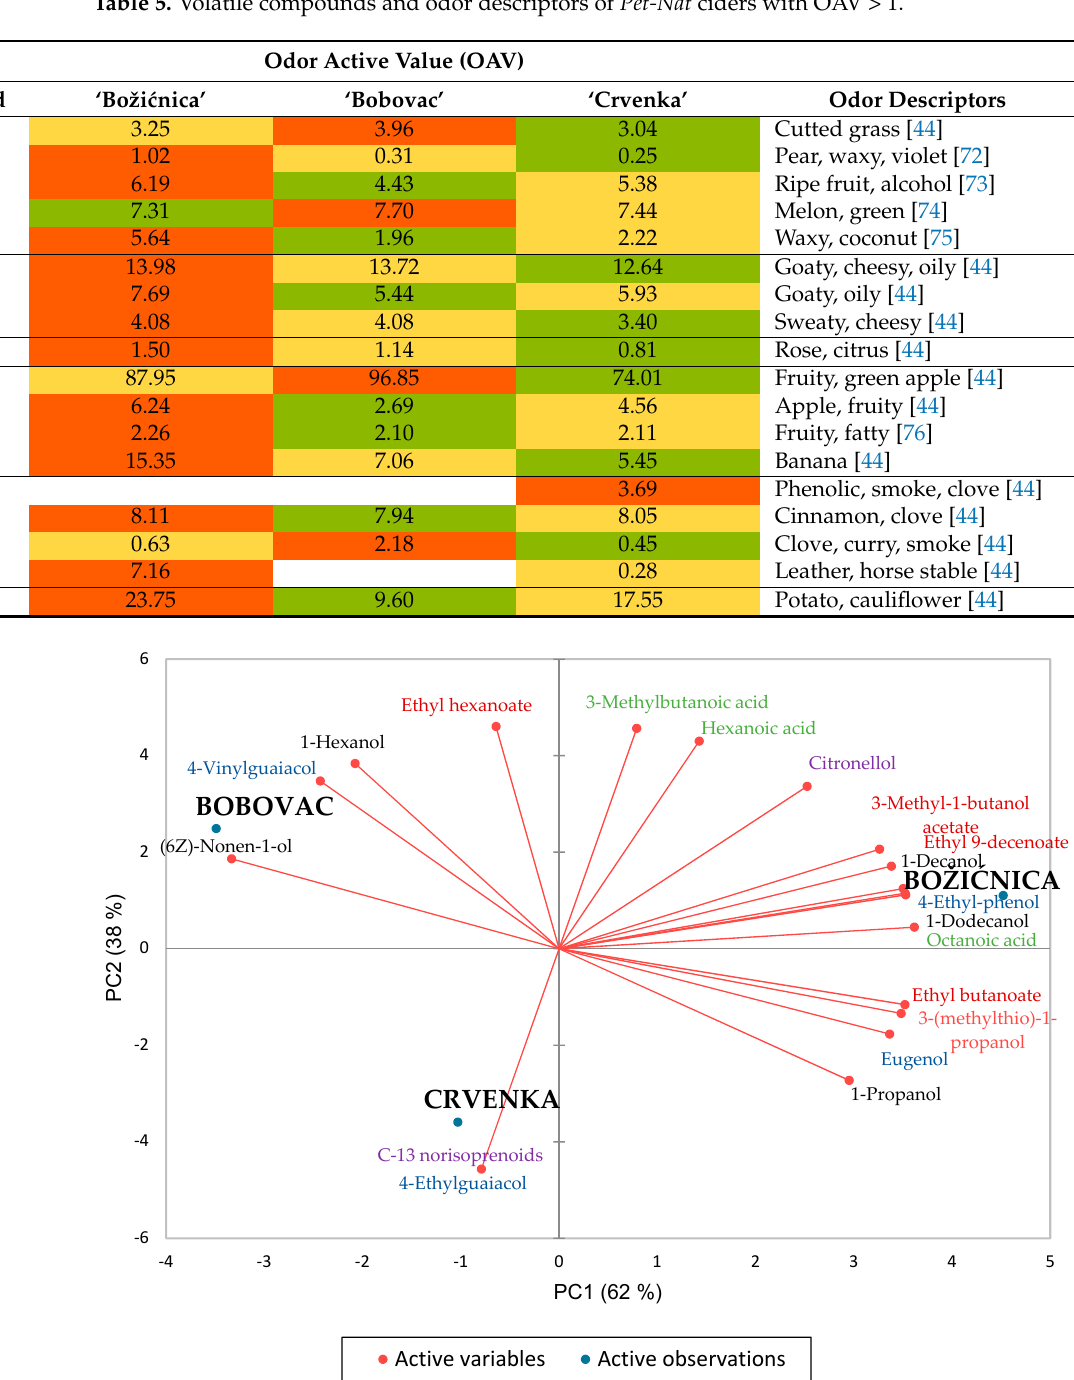
Table 5. Volatile compounds and odor descriptors of P é t-Nat ciders with OAV > 1.